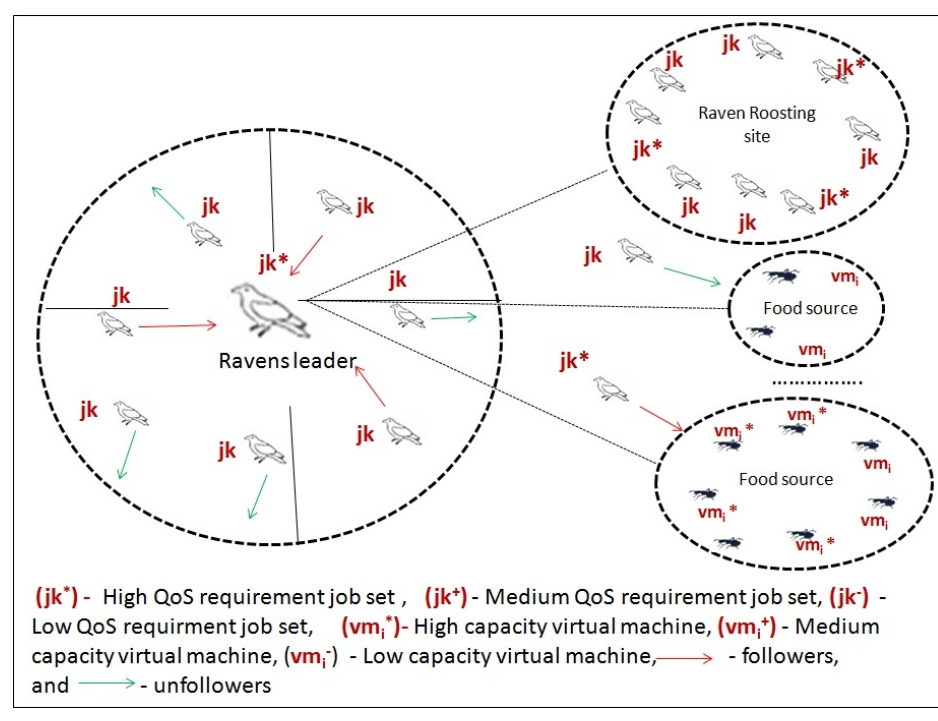
Figure 5: Social roosting behavior of raven roosting load balancing